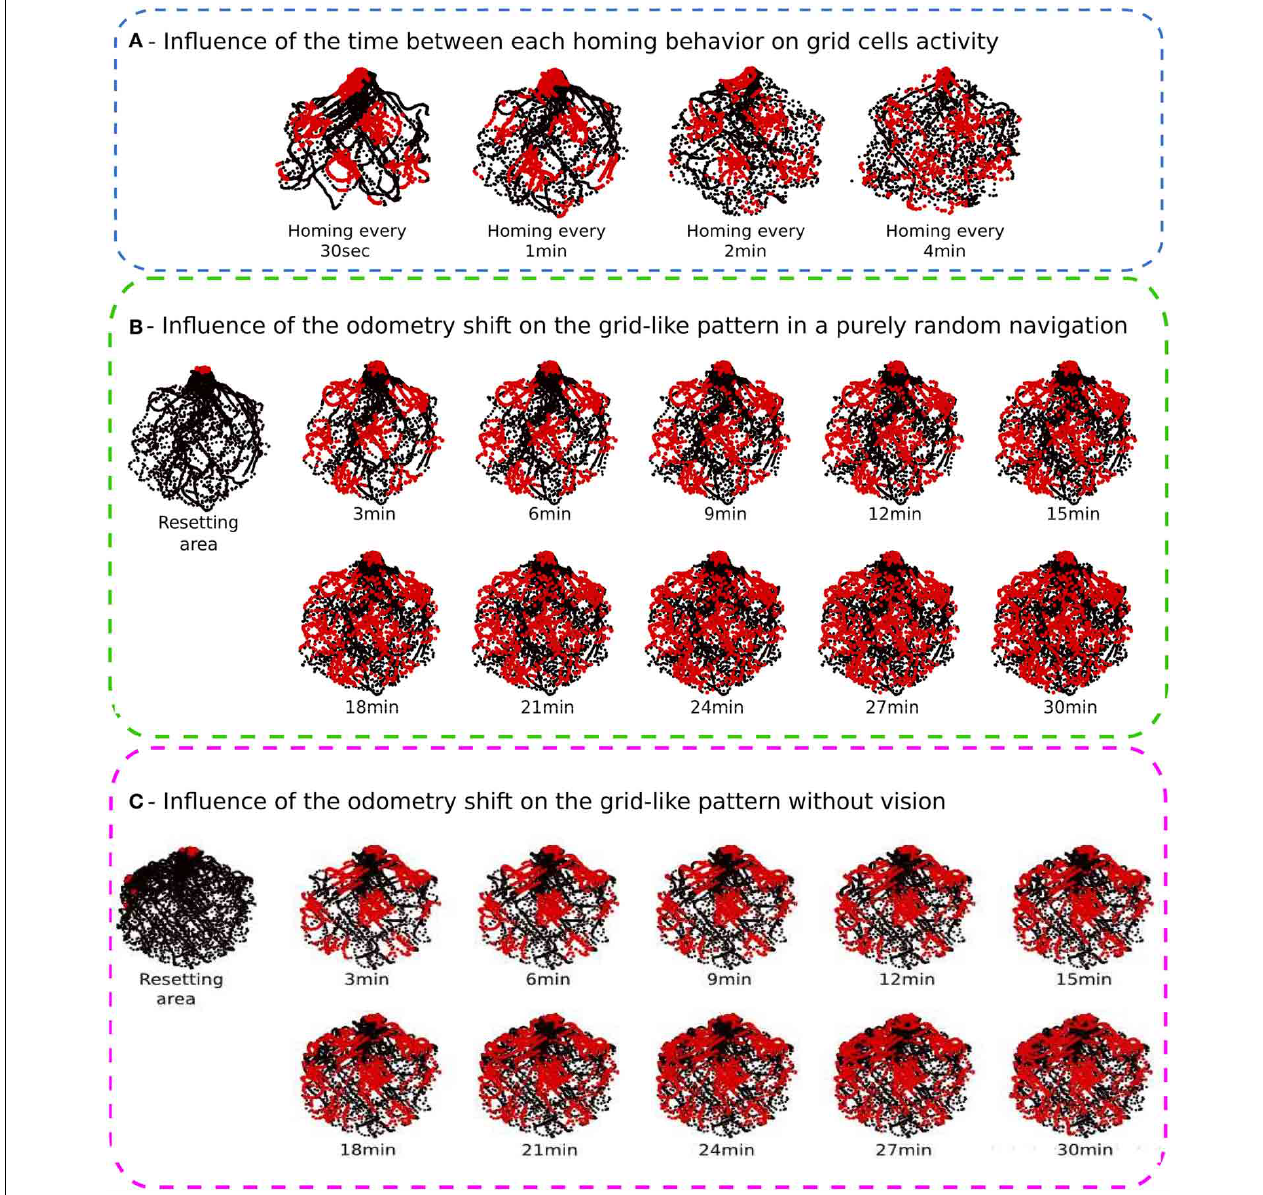
FIGURE 8 | (A) Influence of the time between each homing behavior on grid cell activities (Experiment 2). We made 4 Experiments on a real robot randomly moving during 30 min in the hexagonal enclosure. Activity of a grid cell (red dot) superimposed on a robot path (black dot) for different homing periods. From left to right, the robot go recalibrate itself every 30 s, 1 min, 2 min, and 4 min. The shorter the homing period is, the better the pattern activity is defined. But the robot needs a least 1 min to uniformly cover the entire environment. (B) Influence of the PI shift on the grid-like pattern in a purely random navigation of 30 min (Experiment 4). As for previous experiments, the robot starts a random navigation in the enclosure and uses sensory-motor associations to go recalibrate itself every minute in a corner. After 30 min, we inhibit the homing strategy and the system continues moving for another 30 min without any calibration. Results show, respectively the resetting area (for the first